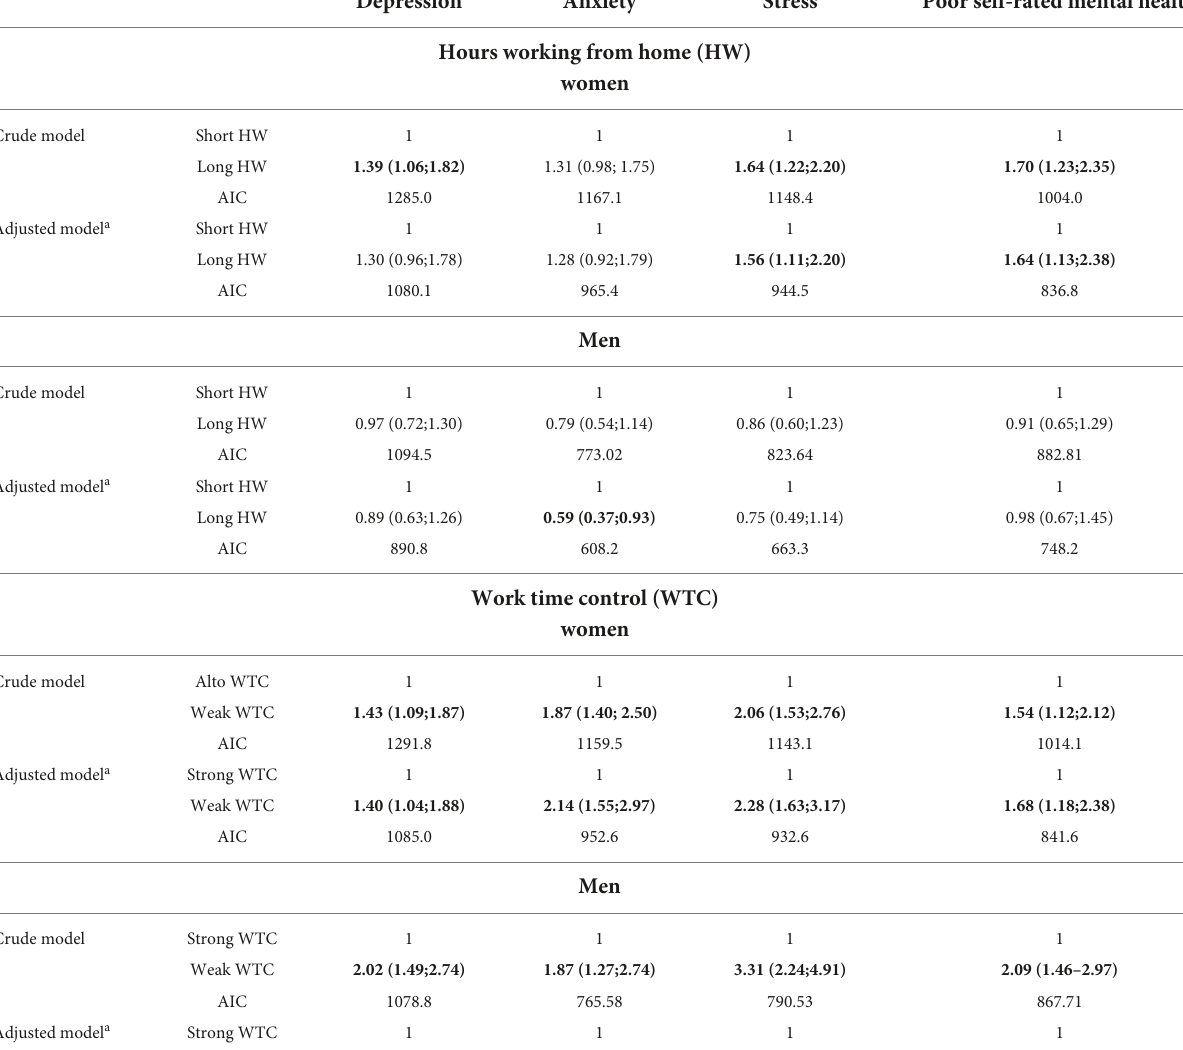
TABLE 3 Crude and adjusted associations (OR 95%CI) between hours worked from home (HW), work time control (WTC), and mental health